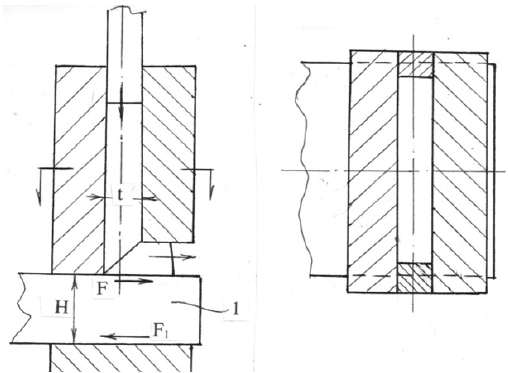
Figure 6. ECAE die with a movable bottom slider for plate billets.